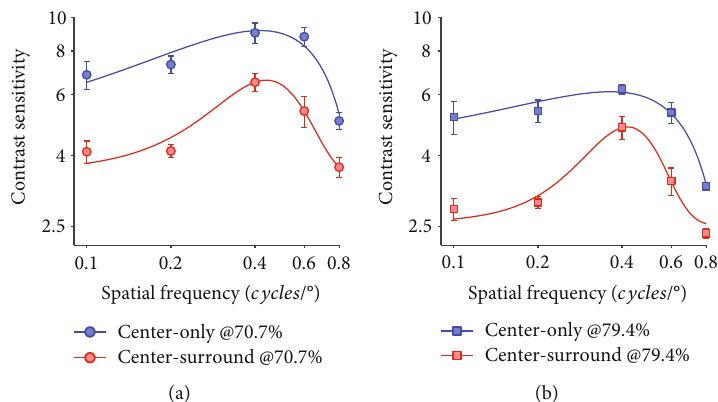
Figure 7: The contrast sensitivity versus stimulus spatial frequency (CSF) functions of NSS neurons ( n = 61 ) measured at performance accuracy of 70.7% (a) and 79.4%, respectively, (b) with (red color) and without (blue color) surround stimuli. The blue and red solid curves were the best fi ts of CSFs with a Gauss function.